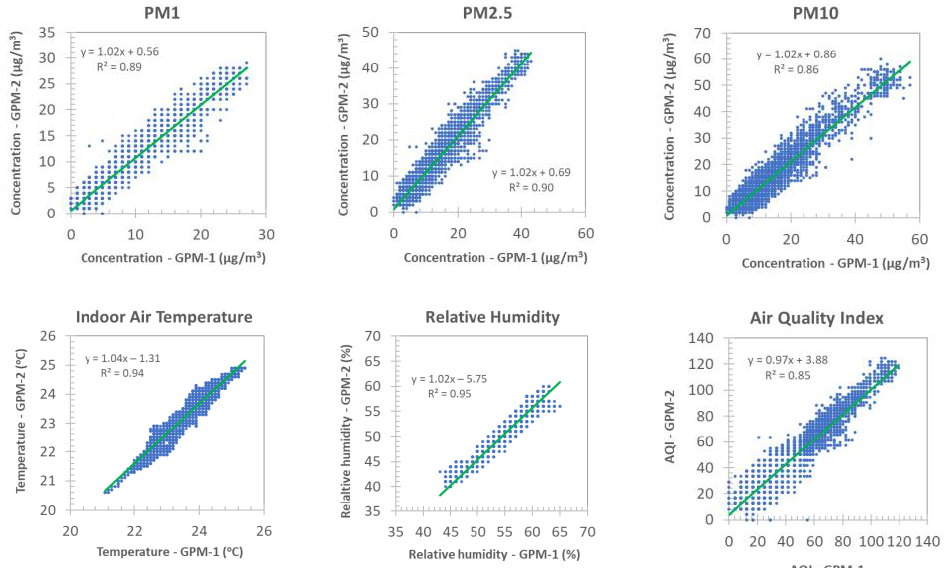
Figure 2. Correlation between data of GPM sensors for indoor air monitoring (living room) at the urban site, performed between 27 and 30 May 2021 (sampling rate: 10 s; n = 28,750).